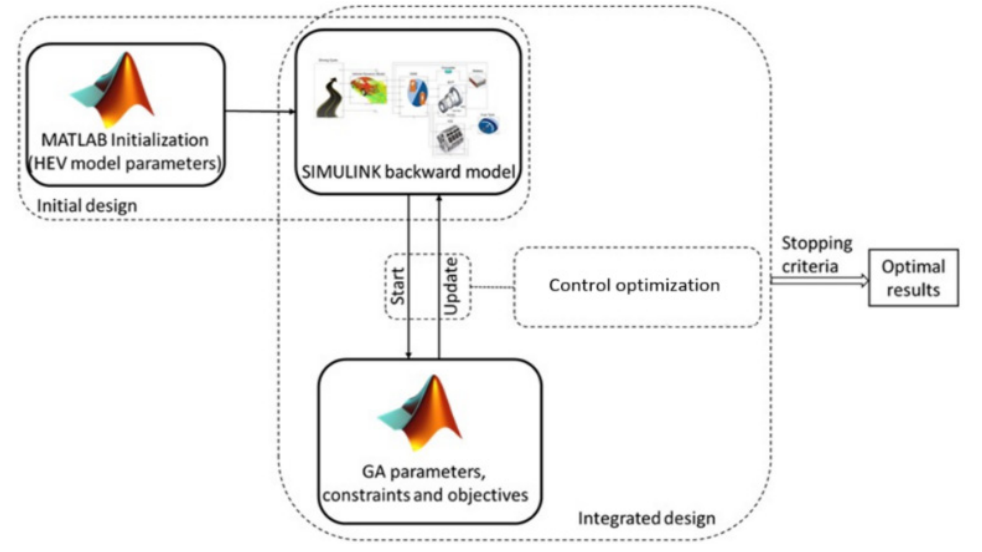
Figure 8. Coordination of the optimization algorithm and the model.